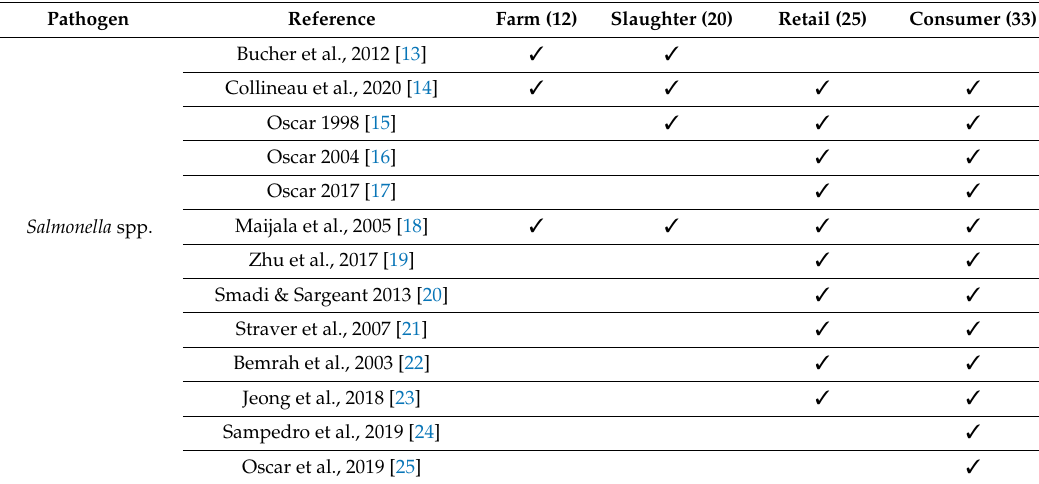
Table 2. Identification of steps of the farm-to-fork chain considered in poultry QMRA papers. Pathogen Reference Retail (25) Consumer (33)